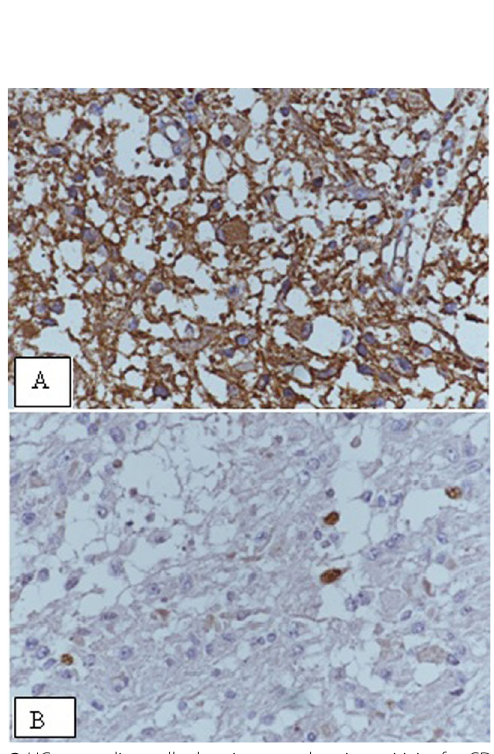
Fig. 3 HC a ganglion cells showing cytoplasmic positivity for CD